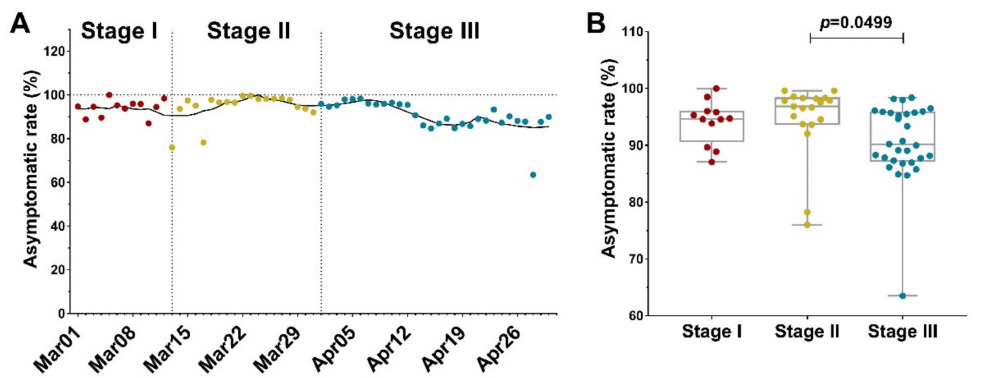
Figure 5. Asymptomatic rate in Shanghai Omicron wave. Asymptomatic rate is the ratio of asymp- tomatic cases to daily new infections. ( A ) Asymptomatic rate (red, yellow, and blue dots for the PHSM Stage I, II, and III, respectively), in Shanghai Omicron wave. Dashed vertical lines indicate the beginning date of Stage II and III (March 13 and April 1, respectively). The data were smoothed following a 7-day averaged, 4th-order polynomial method, and the trend was plotted as black curve. ( B ) The comparison of asymptomatic rate during the three PHSM